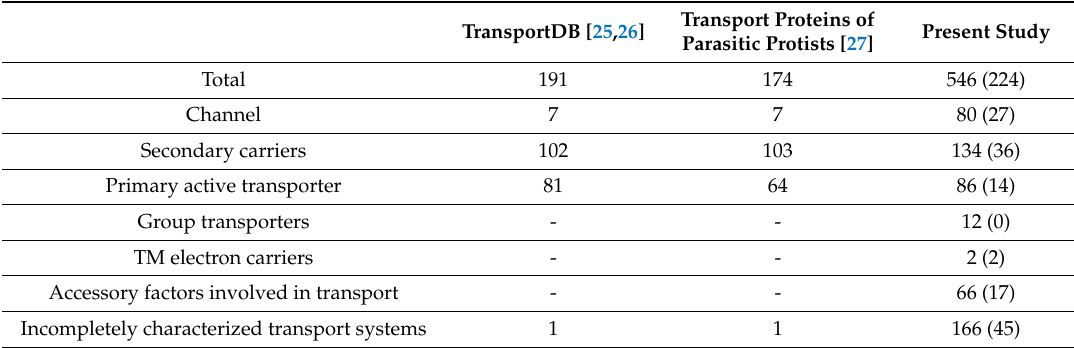
Table 1. Comparison of TM transport proteins reported in previous studies with those that are identified in the present study.